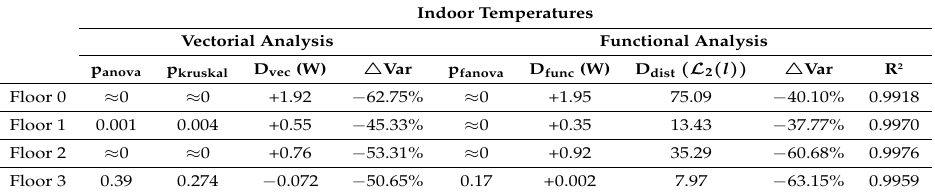
Table 5. Numerical results on each floor indoor temperatures. The vectorial results are presented with D vec measuring the difference between medians. The functional results, accompanied with the average minute difference (D func ), the L 2 ( l ) distance between the functional mean (D dist ) and the smoothing adjustment (R 2 ), are also presented. For both analyses, the change in the variability of the data is displayed ( (cid:52) Var). Lastly, the p -values for the tests, both vectorial and functional, are calculated. Indoor Temperatures Vectorial Analysis Functional Analysis p anova p kruskal D vec (W) (cid:52) Var p fanova D func (W) D dist ( L 2 ( l )) (cid:52) Var R 2 − 62.75% 75.09 − 40.10% 0.9918 − 37.77% 0.9970 − 60.68%